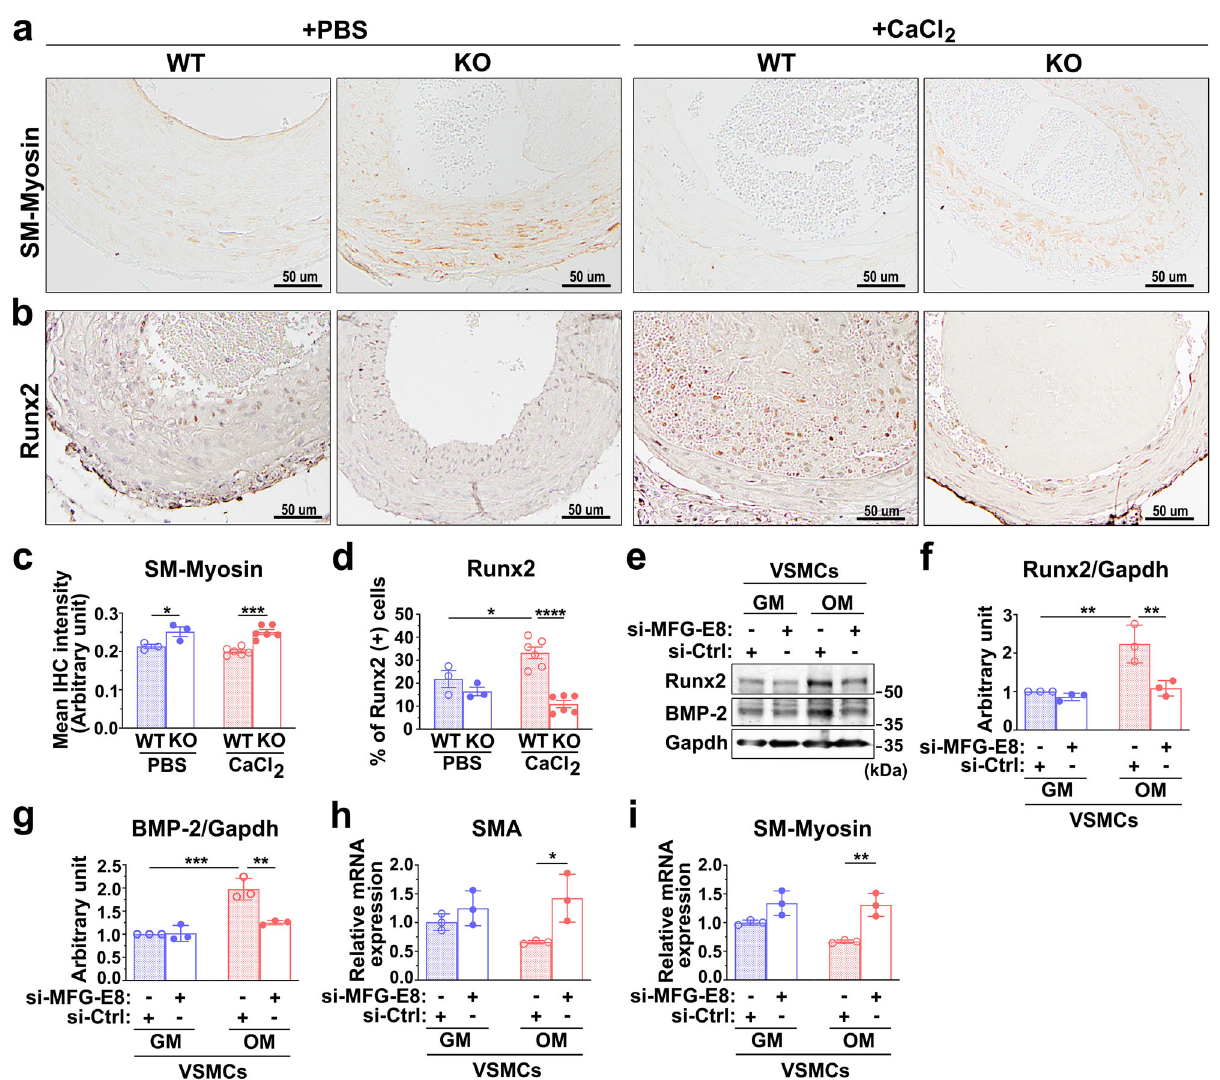
Fig. 4 Milk fat globule – epidermal growth factor 8 (MFG-E8) de fi ciency attenuates osteogenic transdifferentiation of vascular smooth muscle cells (VSMCs) under calcifying conditions. a – d The common carotid arteries (CCAs) of wild-type (WT) and MFG-E8-knockout (KO) mice were ligated, and phosphate-buffered saline (PBS) and CaCl 2 (0.4 M) were applied to vessels using Pluronic gel. a Representative immunohistochemistry (IHC) images of smooth muscle myosin (SM-Myosin) in the CCAs of mice 21 days after ligation. Scale bar: 50 μ m. b Representative IHC photomicrographs of runt-related transcription factor 2 (Runx2) in the ligated CCAs 21 days after the surgery. Scale bar: 50 μ m. c Quantitative analysis of the immunostaining intensities of SM-Myosin in the intimal medial area was performed (WT + PBS: n mice = 3, KO + PBS: n mice = 3, WT + CaCl 2 : n mice = 6, and KO + CaCl 2 : n mice = 6). Data are presented as mean ± standard error of the mean (SEM). Each data point is derived from an assessment of three sections of one individual animal. * P < 0.05 and *** P < 0.001, as obtained using one-way analysis of variance (ANOVA) followed by Tukey ’ s multiple comparisons test. d Quantitative IHC analysis of the percentage of Runx2-positive cells over total cell number in the intimal medial area (WT + PBS: n mice = 3, KO + PBS: n mice = 3, WT + CaCl 2 : n = 6, KO + CaCl n = 6). Data are presented as mean ± SEM. Each data point is derived from an assessment of three sections of one individual animal. * P < 0.05 and **** P < 0.0001, as obtained using one-way ANOVA followed by Tukey ’ s multiple comparisons test. e – i A10 VSMCs that underwent 48-h transfection with siRNA against MFG-E8 (si-MFG-E8) or control siRNA (si-Ctrl) were cultured in the growth medium (GM) and osteogenic medium (OM) for 7 days. e Immunoblotting of the protein expression of Runx2 and bone morphogenetic protein-2 (BMP-2) in A10 cells was performed. Quantitative analyses of Runx2 ( f ) and BMP-2 ( g ) normalized to glyceraldehyde 3-phosphate dehydrogenase (GAPDH) were conducted ( n = 3). Data are presented as mean ± standard deviation (SD). Three independent experiments were performed. Each data point is derived from each of the three repeated experiments. ** P < 0.01 and *** P < 0.001, as obtained using one-way ANOVA followed by Tukey ’ s multiple comparisons test. The transcript expression of smooth muscle α -actin (SMA) ( h ) and SM-Myosin ( i ), respectively, was evaluated through quantitative real-time polymerase chain reaction ( n = 3). Three independent experiments were performed. Data are presented as mean ± SD. Each data point is derived from each of the three repeated experiments. * P < 0.05 and ** P < 0.01, as obtained using one-way ANOVA followed by Tukey ’ s multiple comparisons